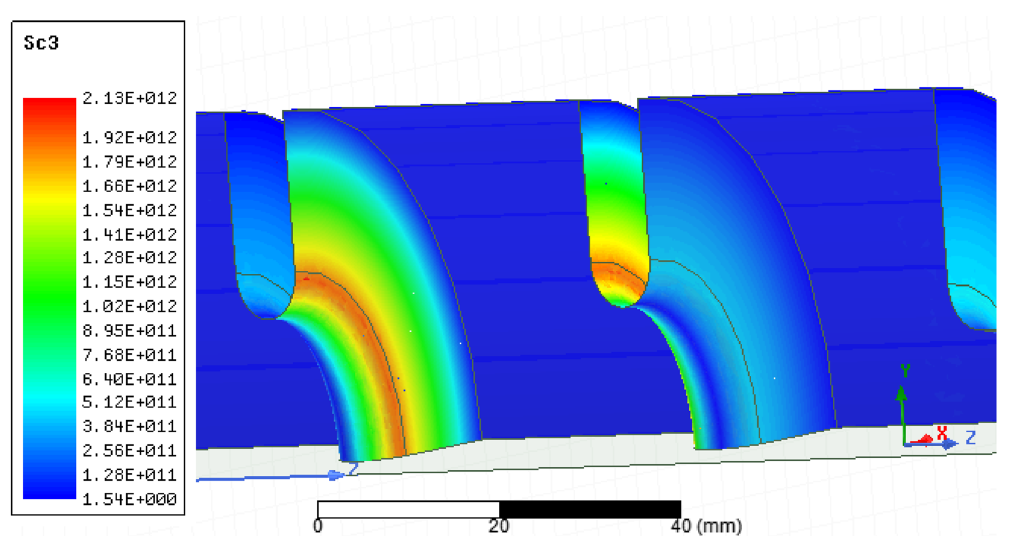
Figure 9. The modified Poynting vector (Sc) parameter for 8 MW input